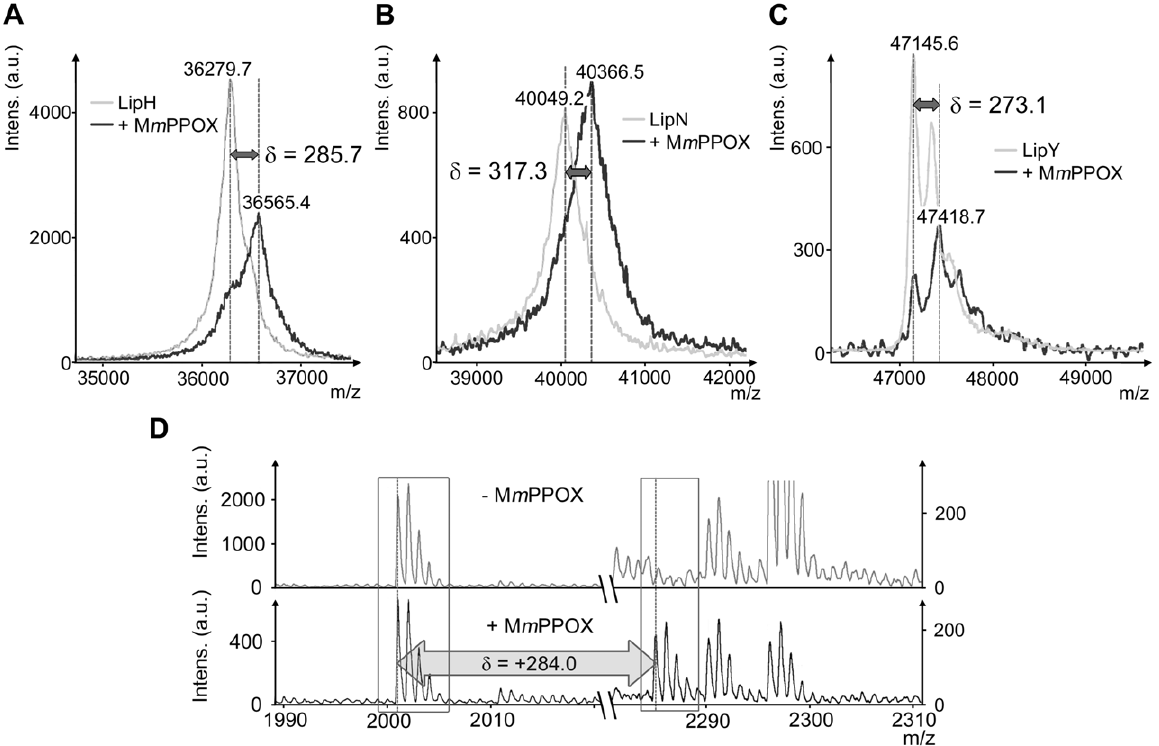
Figure 3. Protein-inhibitor adducts studies using mass spectrometry. Global mass modifications of A , LipH; B , LipN and C , LipY after 30 min incubation with M m PPOX at a molar excess of 20 ( x I =20). D , PMF spectra of LipN before (top) and after (bottom) 30 min incubation with M m PPOX at a molar excess of 20 ( x I =20). Only two parts of interest are shown: left part, area for a catalytic peptide, containing the unmodified catalytic Serine ( m/z , 2001.0); right part, area expected for the appearance of a new signal for the catalytic peptide following reaction of the catalytic Serine with M m PPOX ( m/z , 2285.0; d = + 284.0). Note that, for the sake of clarity, different vertical scales were chosen for the left parts, but identical vertical scales were chosen for the right